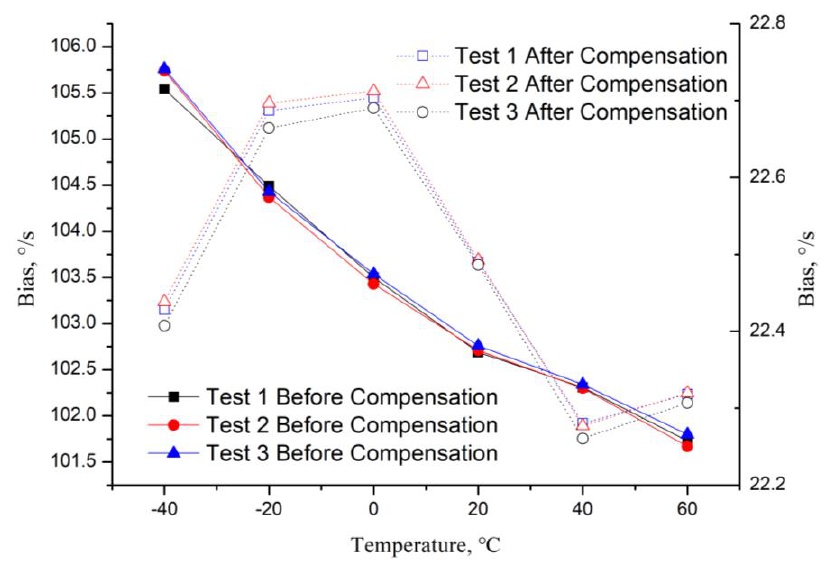
Figure 11. MEMS gyroscope temperature bias compensation results.